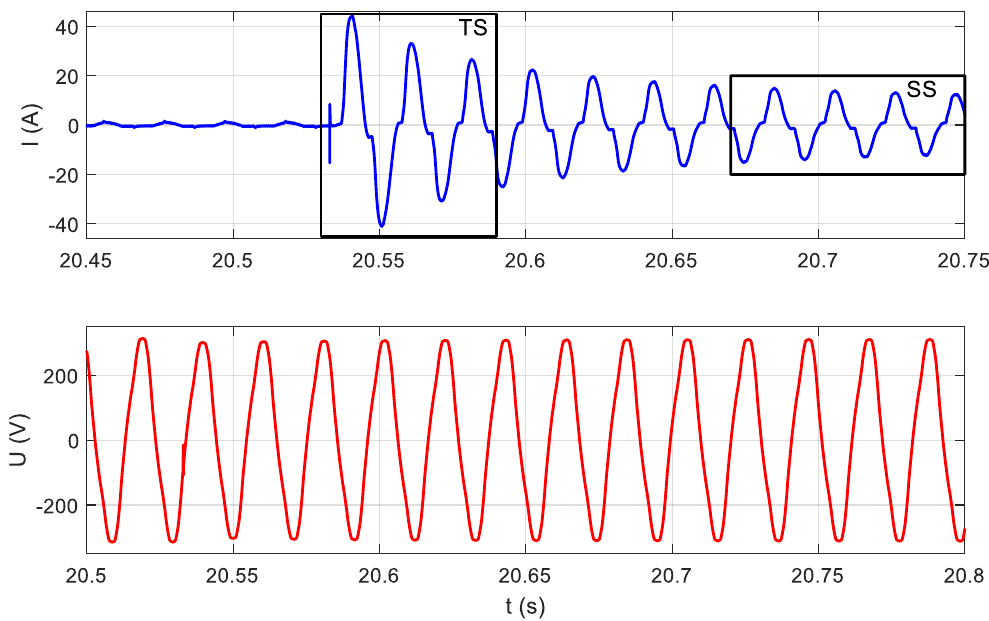
Figure 5. Moment 3, the vacuum cleaner switching on, in the scale of milliseconds.